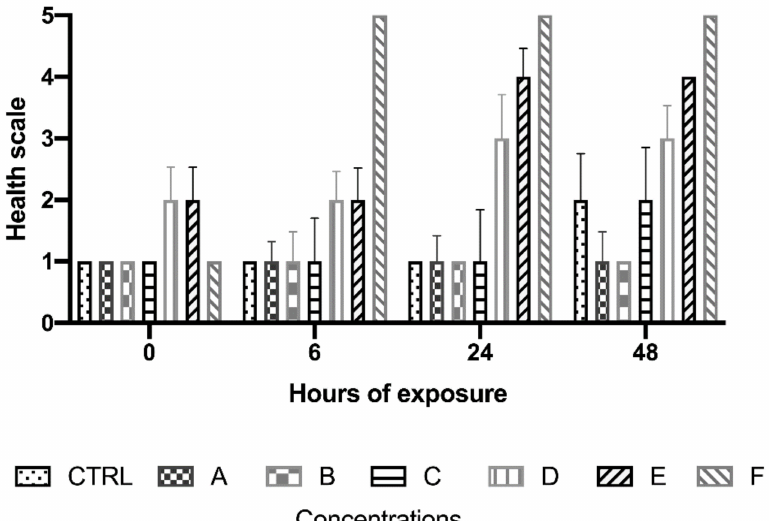
Figure 7. Effect of the exposure of Botryllus shlosseri to copper at 6 concentrations, as compared to controls, checked at four time-intervals (from t 0 to t 48 ). The patterns of bars indicate concentrations. Scores from 1 to 5 on the abscissa are referred to health classes indicated in Table 2.